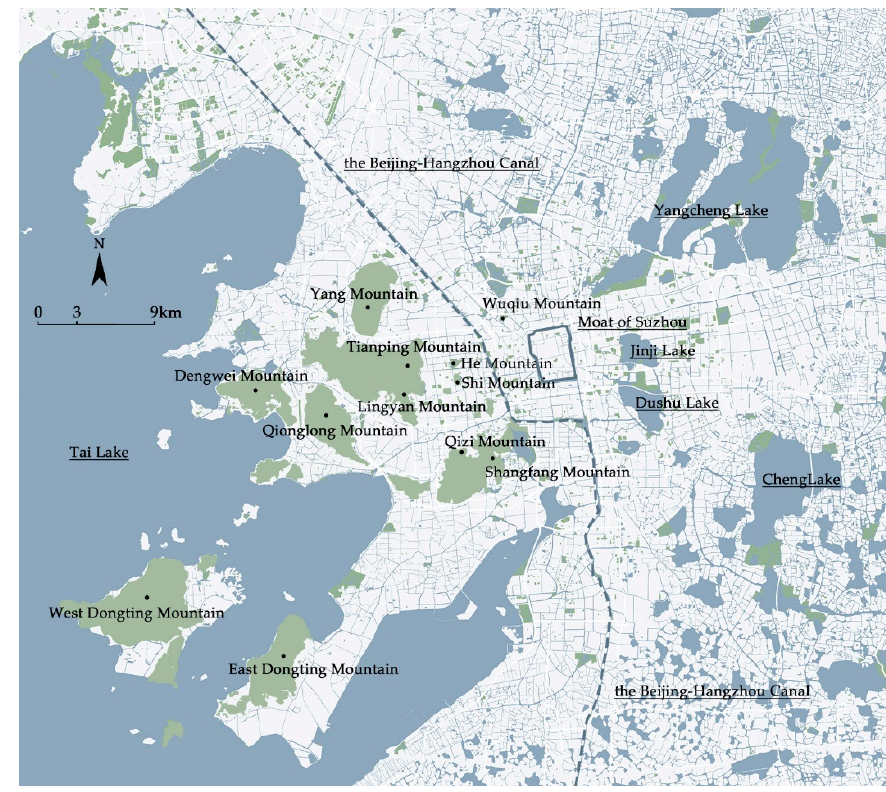
Figure 3. Natural environment of Suzhou.